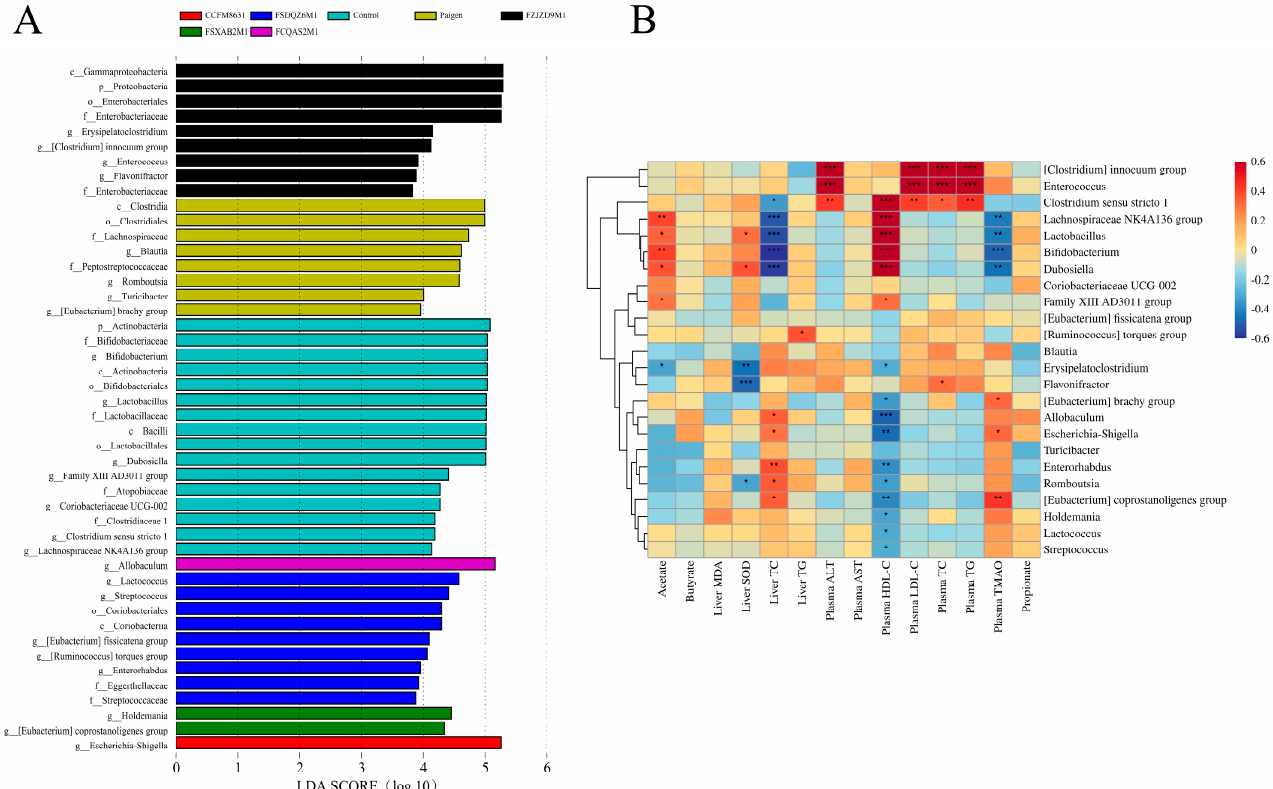
Figure 6. Lactobacillus and Bifidobacterium could remodel the structure of the flora microbiota. ( A ) Plot LEfSe Results of microbial faeces. LDA > 2, p < 0.05 ( B ) Correlation between measured indicators and genus with significant differences. * p < 0.05, ** p < 0.01, *** p < 0.001.